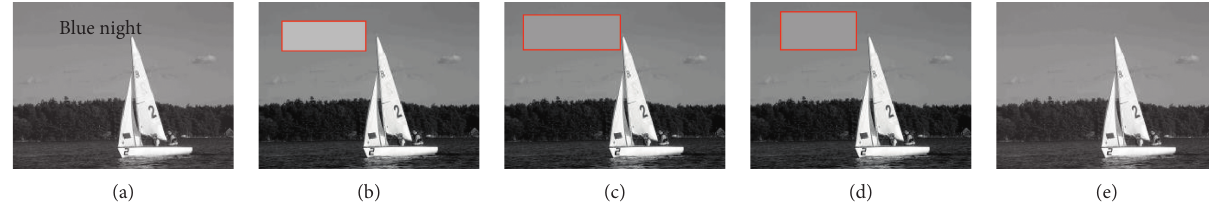
Figure 9: Comparison of the effect of the letter removal grayscale image restoration. (a) Original image, (b) Criminisi algorithm result, (c) adaptive repair algorithm result, (d) sparsity repair algorithm result, and (e) algorithm result of this paper.